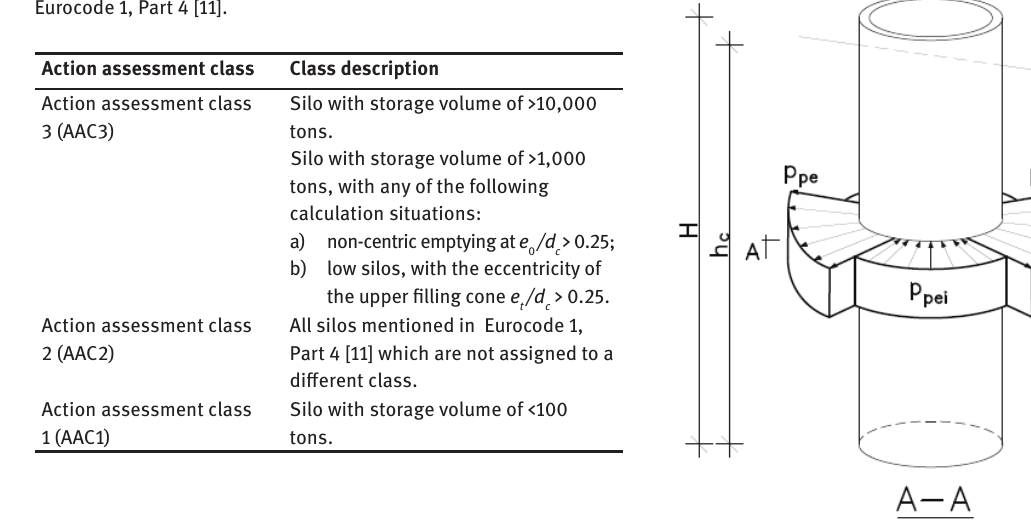
Fig. 2. Non-centric flow channel during emptying and distribution of pressure on the silo wall [12]